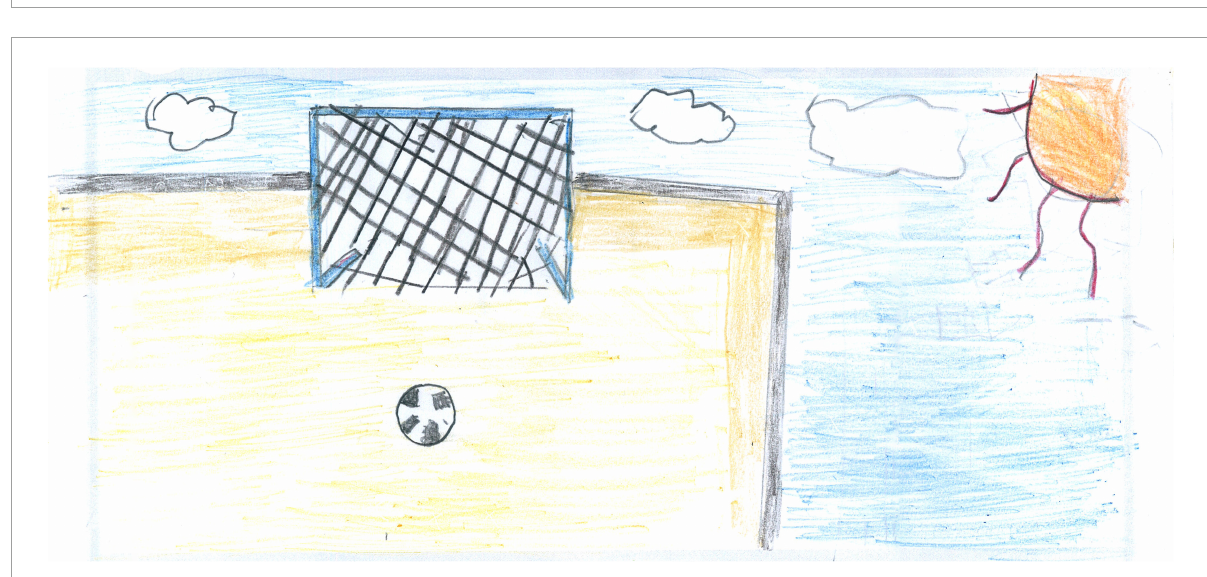
FIGURE4 A different example of a drawing with no people. The playfield is empty, but the drawing is full of color, sunlight, and that ball in front of the net is “asking” to be kicked soon (PS, Male, 10